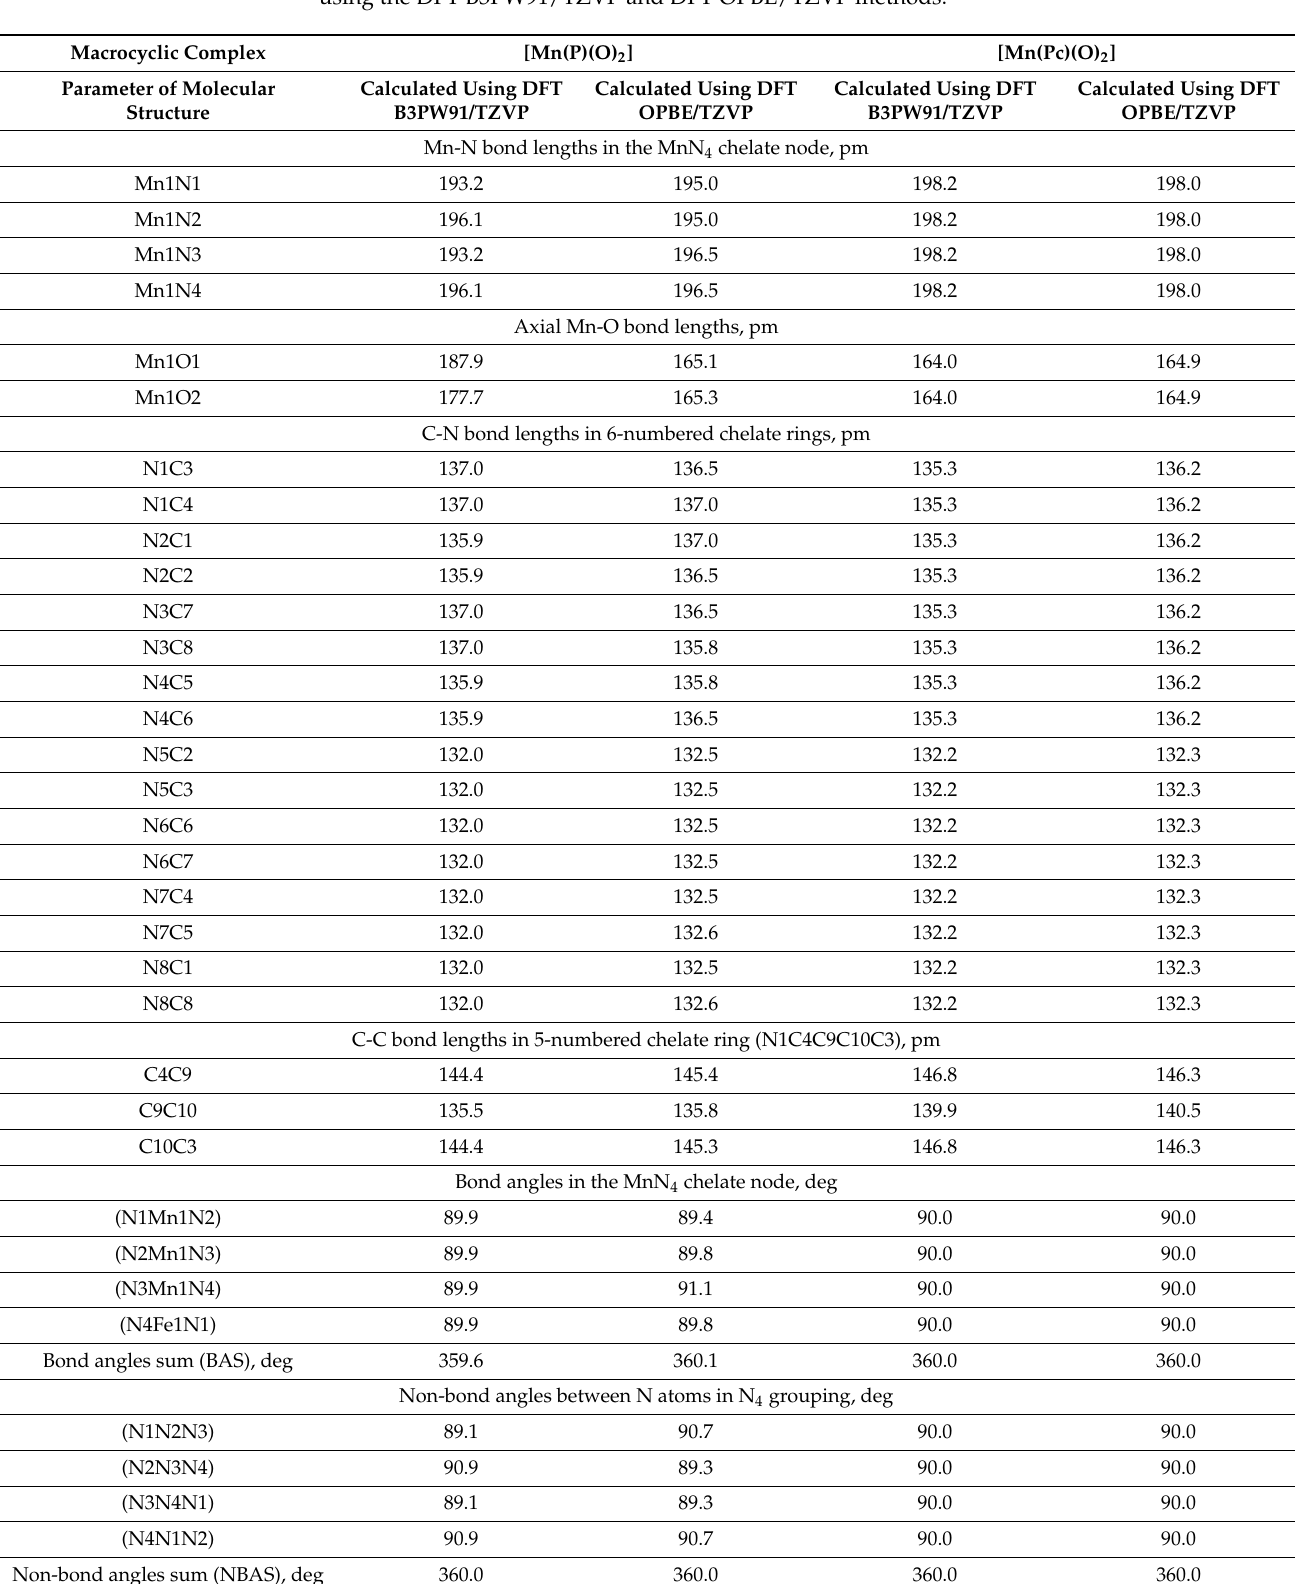
Table 1. Bond lengths and bond angles in the [Mn( P )(O) 2 ] and [Mn( Pc )(O) 2 ] complexes, calculated using the DFT B3PW91/TZVP and DFT OPBE/TZVP